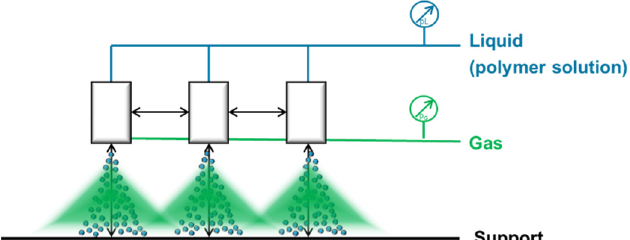
Figure 13. Setup for the overlapping of three 2-fluid nozzles. The support is moving perpendicular to the scheme.